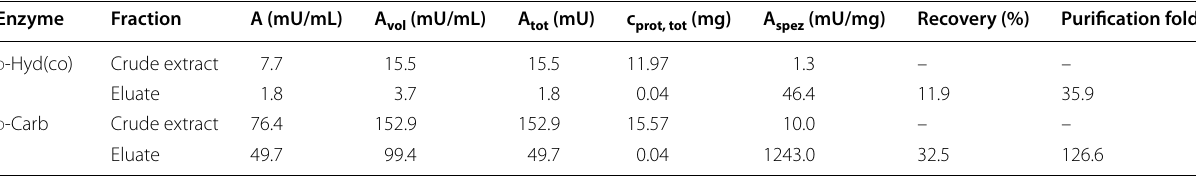
a Eluate 1 and 2: subsequent elutions of the same pulldown Table 2 Purification of the d -Hyd(co) and d -Carb via functionalized magnetic beads Enzyme